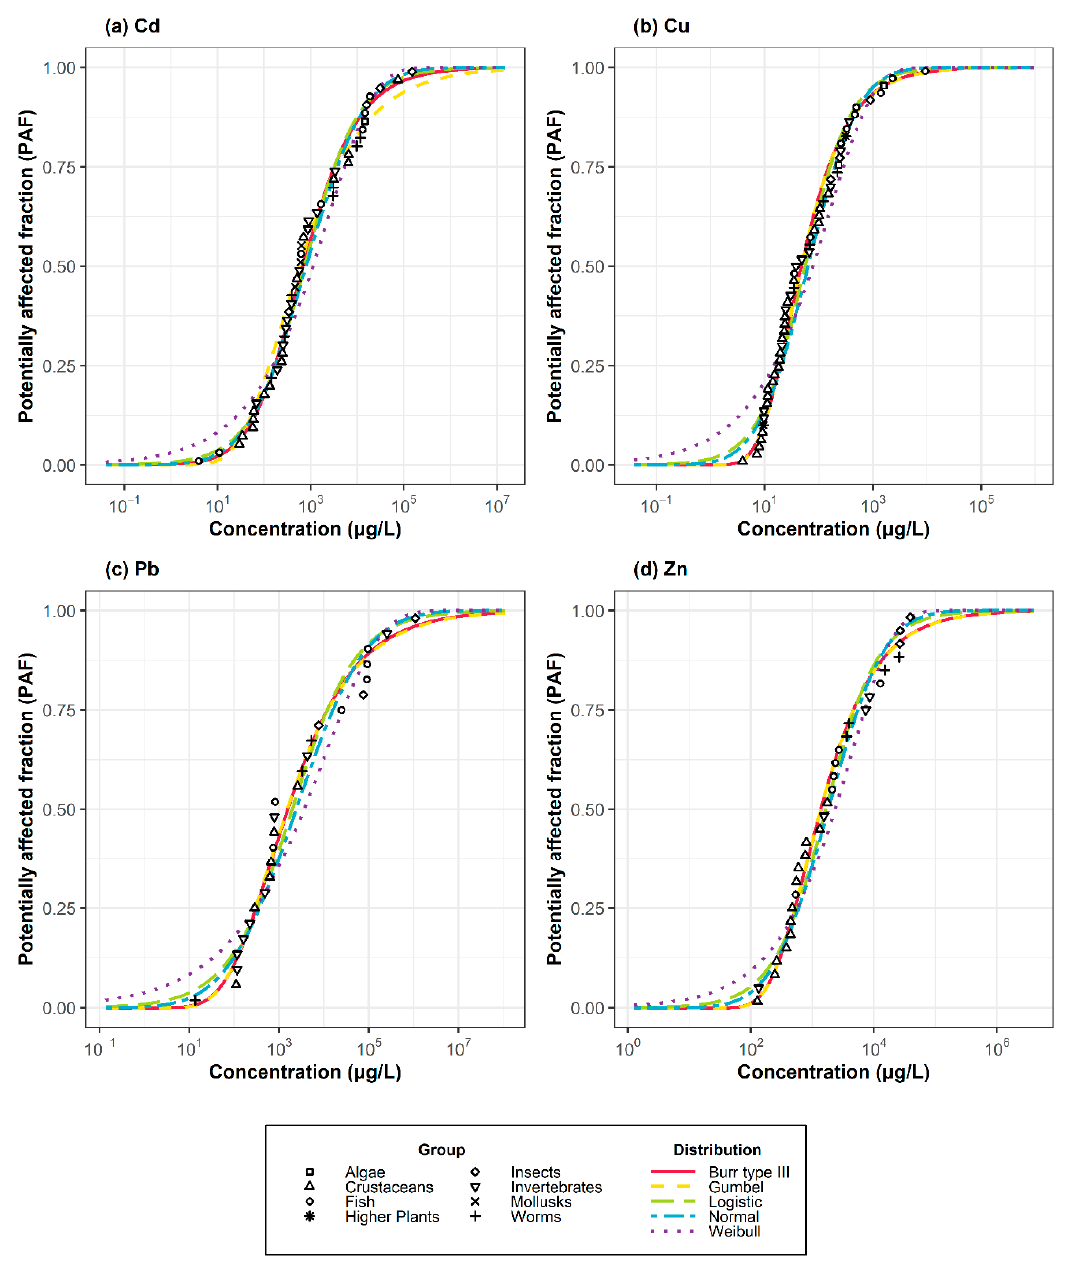
Figure 4. Five species sensitivity distribution (SSD) models of Korean resident species for ( a ) Cd, ( b ) ( c ) Pb, and ( d ) Cu, ( c ) Pb, and ( d ) Zn .